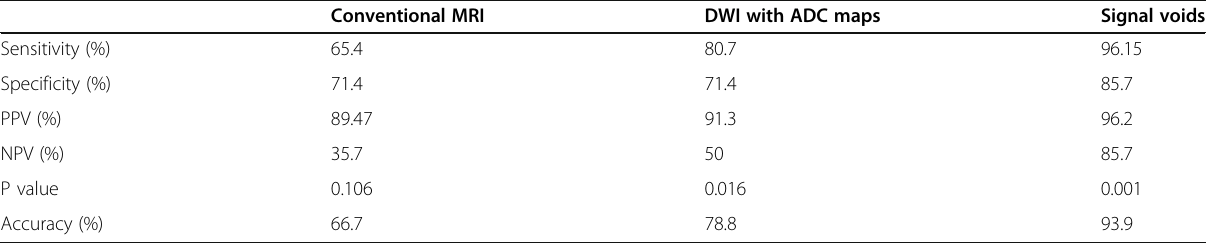
PPV positive predictive value, NPV negative predictive